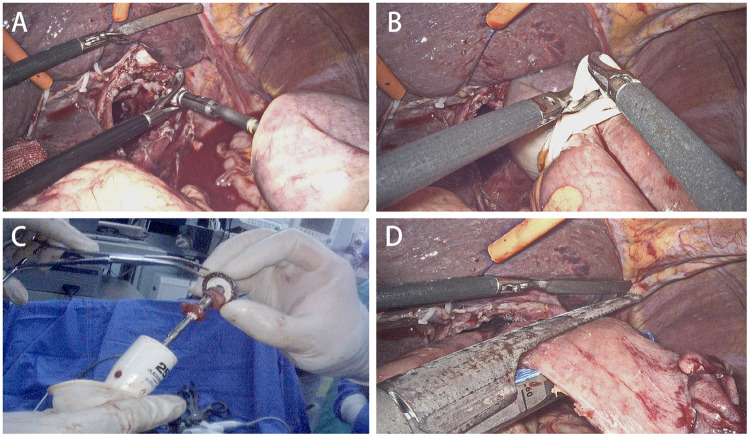
Intracorporeal esophagojejunostomy. (A) The circular stapler and the anvil in the oesophageal stump were linked and fired. (B) Cutting off the rubber band. (C) Taking out the circular stapler and checking the incisal margin after completion of esophagojejunostomy. (D) The jejunal stump was shut down with a linear stapler.